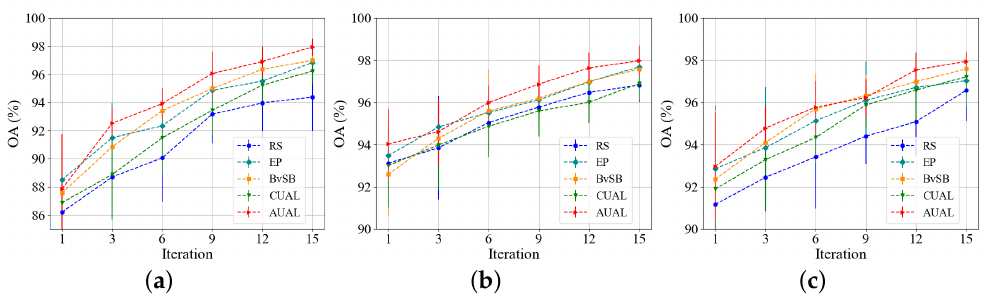
Figure 8. Evolution of OA (%) obtained by different active learning strategies as a function of iteration. ( a ) PaviaU, ( b ) Salinas, ( c )